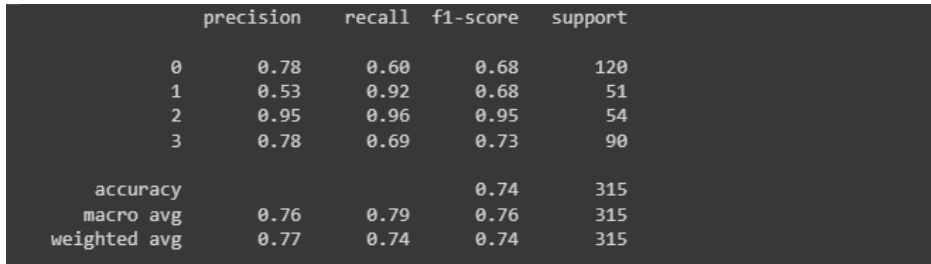
Figure 11. Accuracy and losses when teaching the first model.